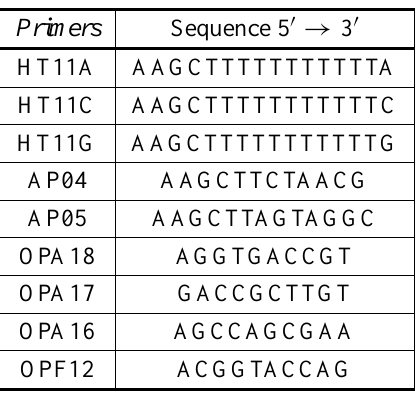
Sequences of oligo-dT (HT11) and arbitrary (AP, OPA and OPF) primers employed for DDRT-PCR